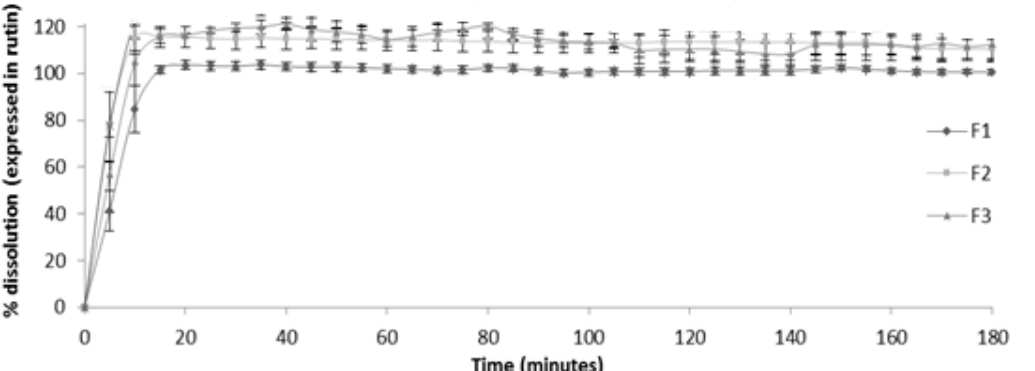
Figure 4. Dissolution profiles for the different developed formulations. F1—extract and corn starch; F2—extract and lactose